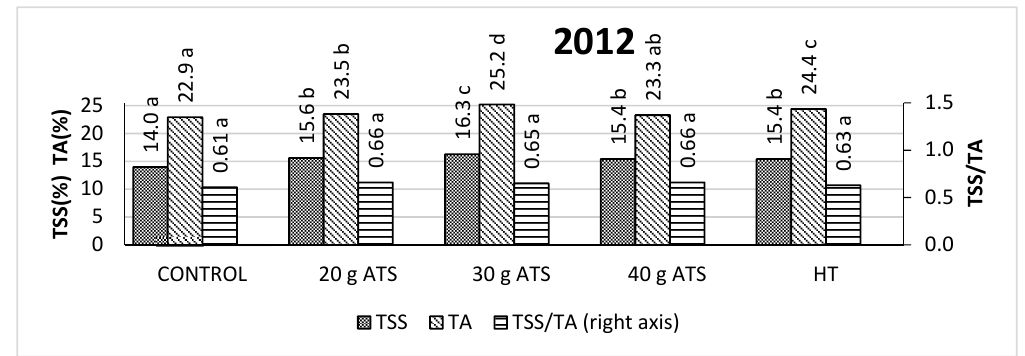
Figure 7. The effect of thinning on mean total soluble solids (TSS), titratable acidity (TA) and TSS/TA ratio of ‘Regina’ sweet cherry fruit in 2009–2012. 1 One-way analyses of variance; data in bars filled with the same pattern, marked with the same letter, are not significantly different at α = 0.05 (Duncan’s test).